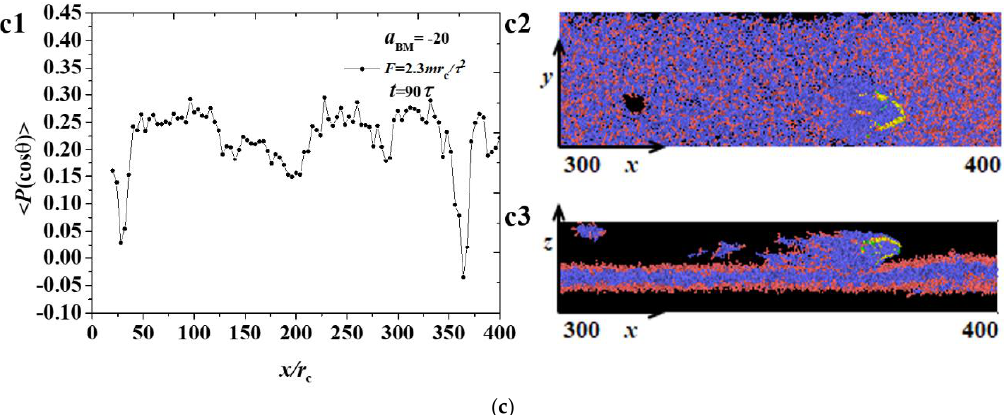
Figure 10. The distribution of order parameters P ( cos θ ) for the phospholipid membrane in the strong adsorption cases of a BM = − 20 and F = 2.3 mr c / τ 2 , where the membrane structures are also displayed. Three time stages, ( a ) t = 0 τ , ( b ) t = 40 τ , and ( c ) t = 90 τ , are demonstrated.